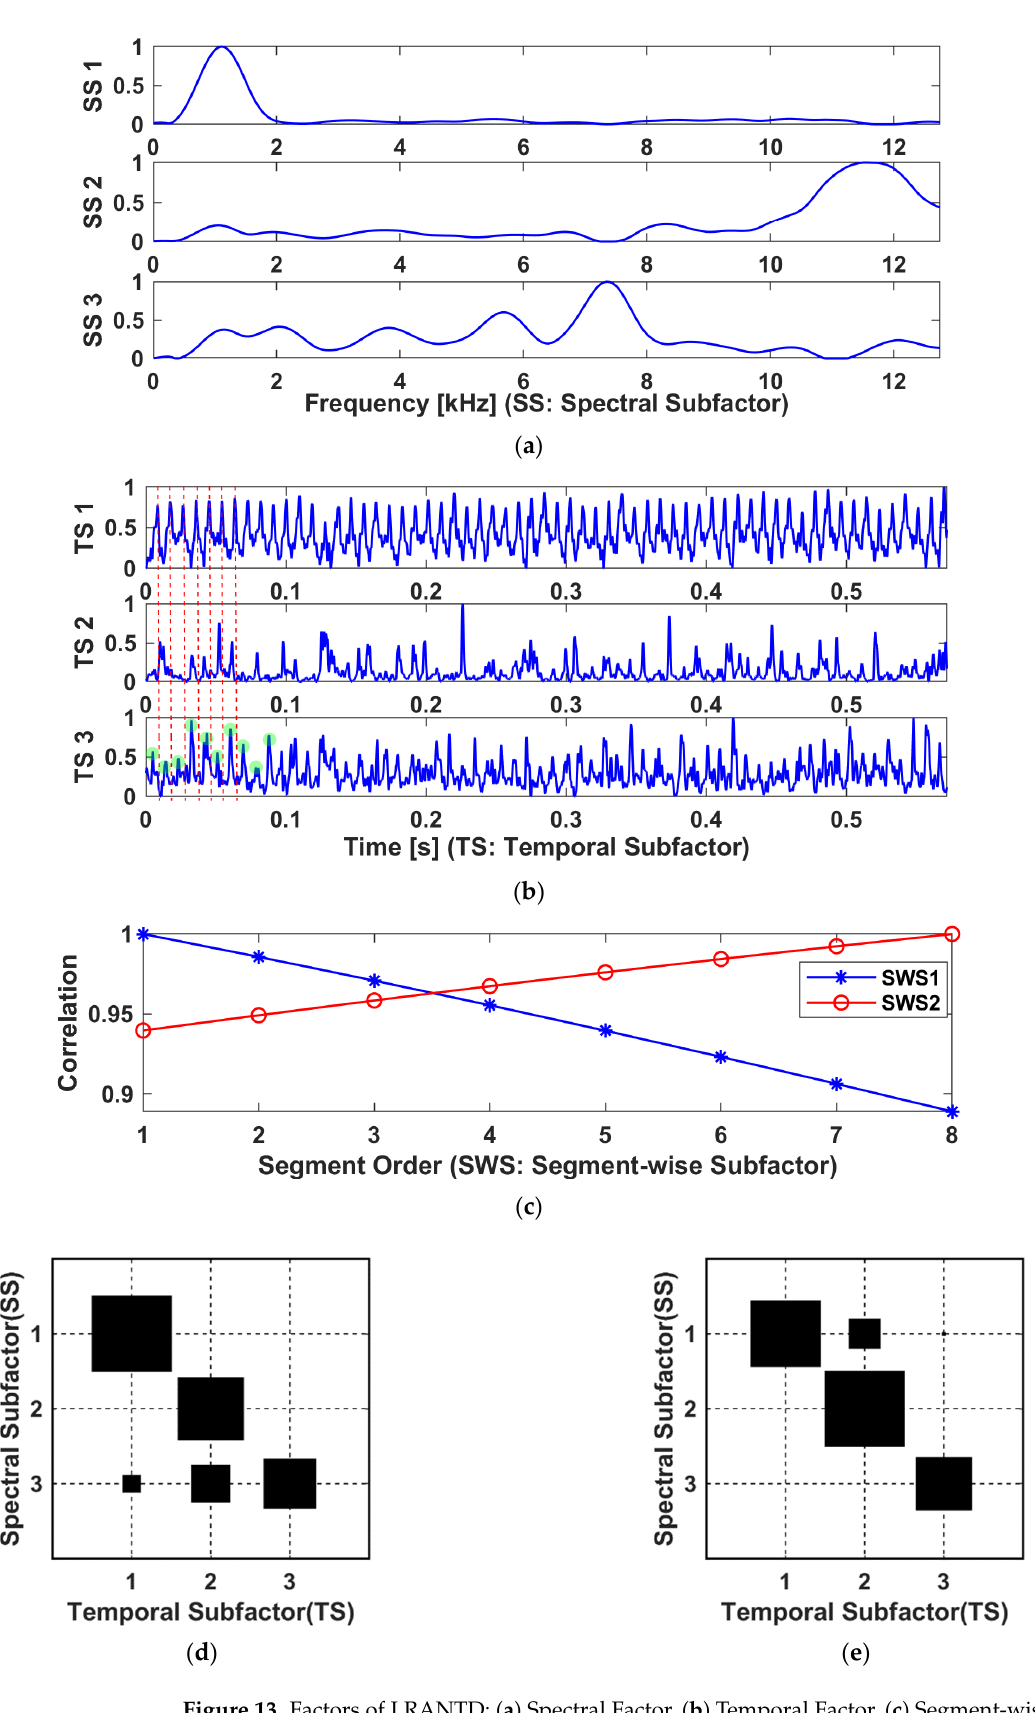
Figure 13. Factors of LRANTD: ( a ) Spectral Factor, ( b ) Temporal Factor, ( c ) Segment-wise Factor, and ( d ) the Core Tensor represented via the frontal slice 1 and ( e ) the frontal slice 2.